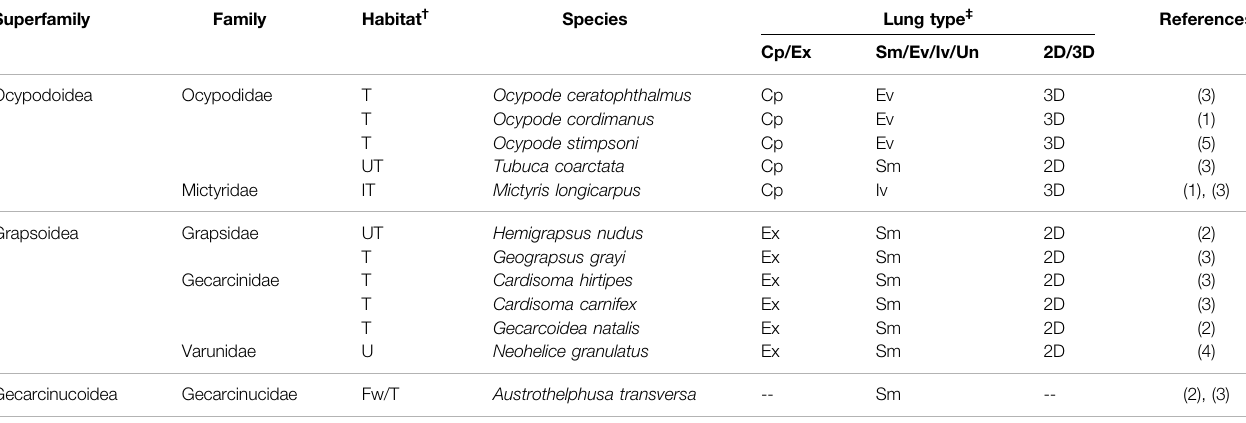
TABLE 1 | Lung types and habitats of crabs among